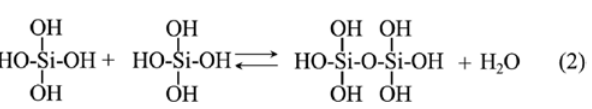
Figure 1: Schematic illustration of SiO brane by sol-gel